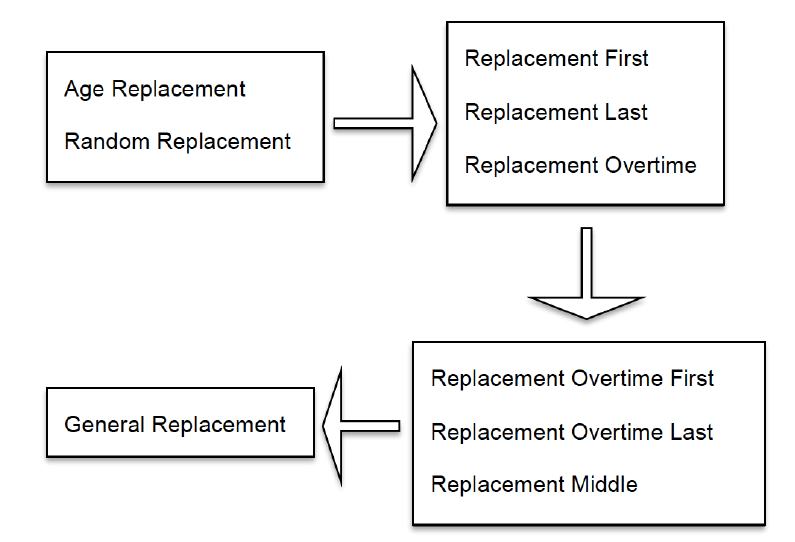
Fig. 1. The evolution of age replacement